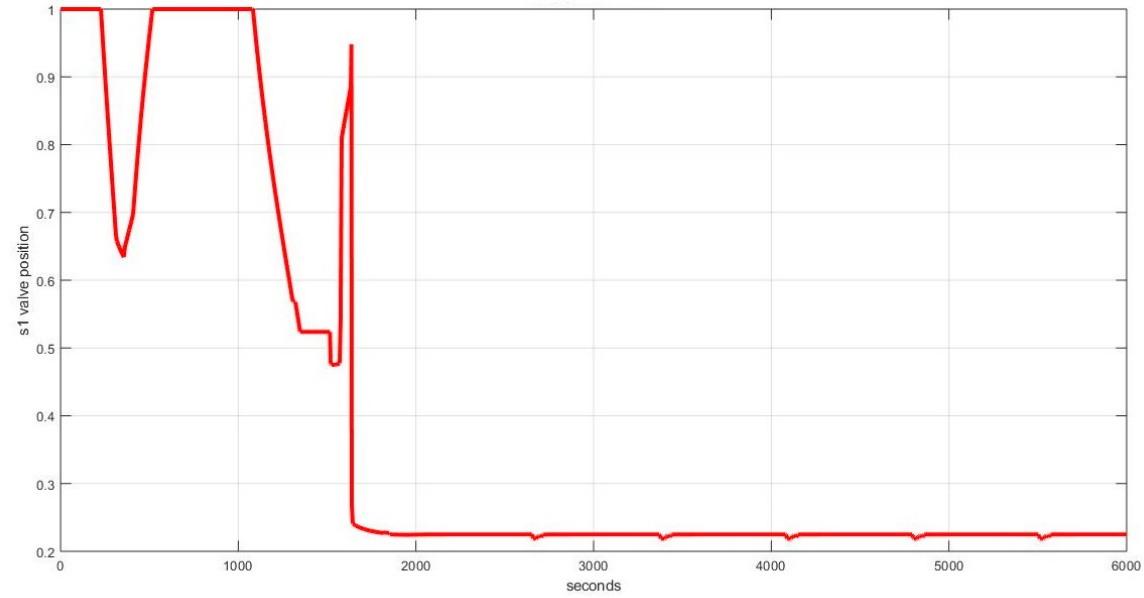
Figure 16. s1 control variable indicating the valve position for the case sinusoidal disturbance.